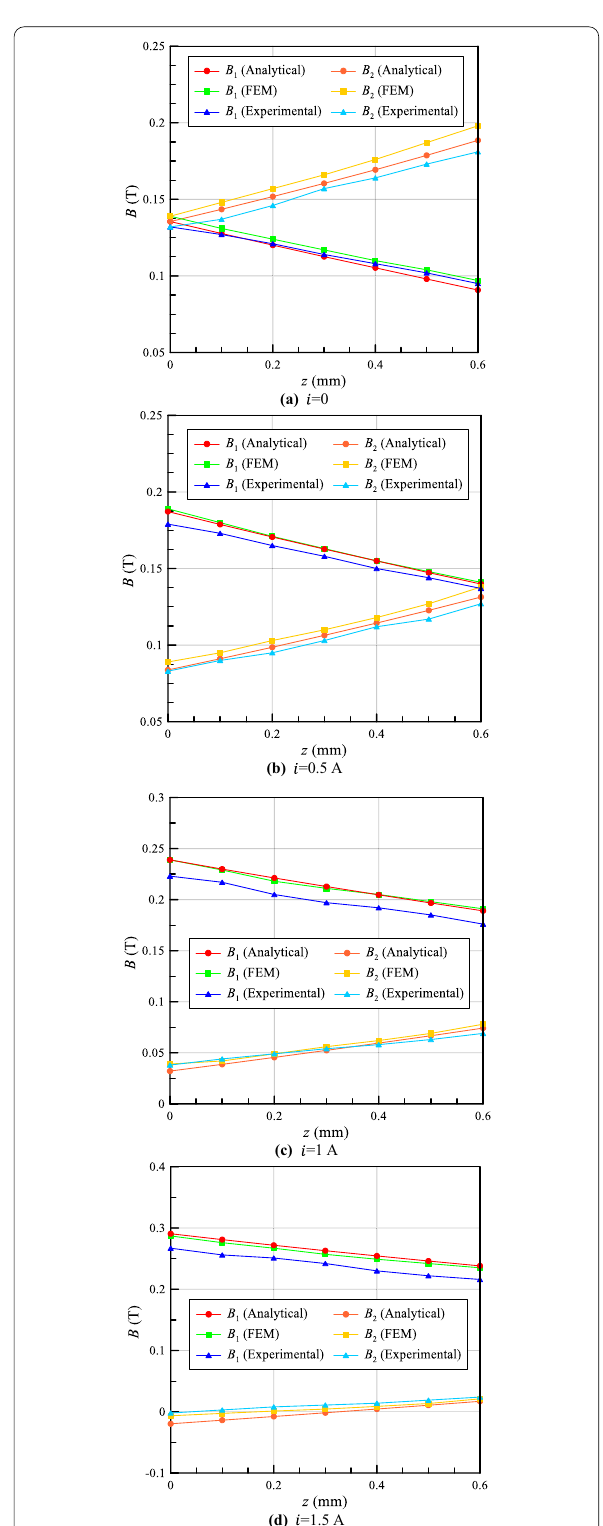
Figure 24 Magnetic flux densities under different currents and